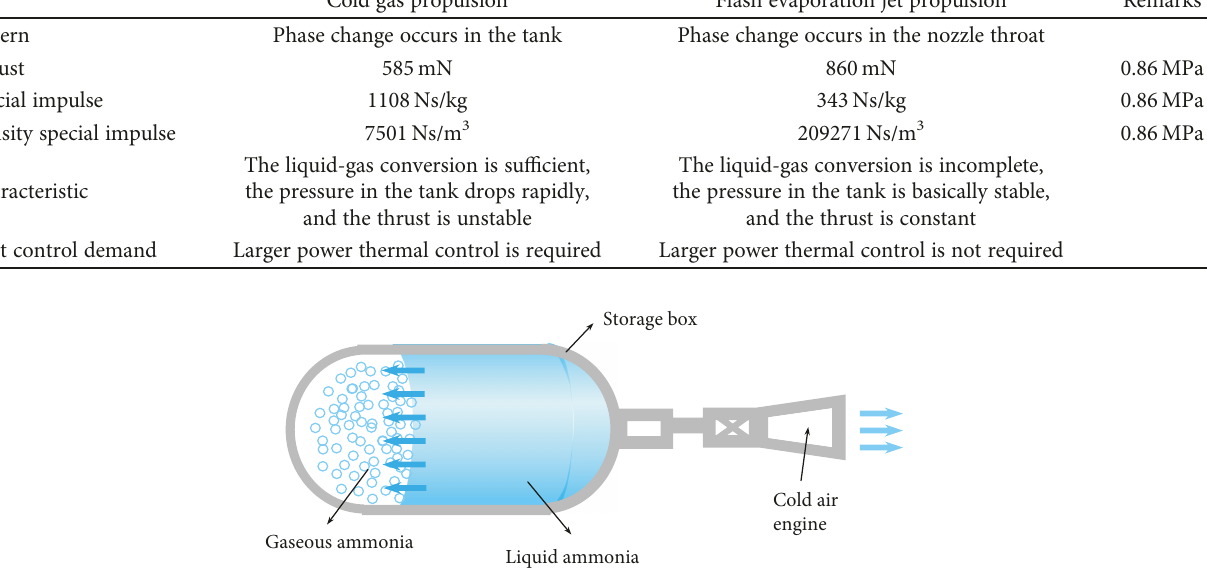
Figure 9: Working principle of the fl ash evaporation jet propulsion program. Table 2: Flight veri fi cation data for the propulsion system